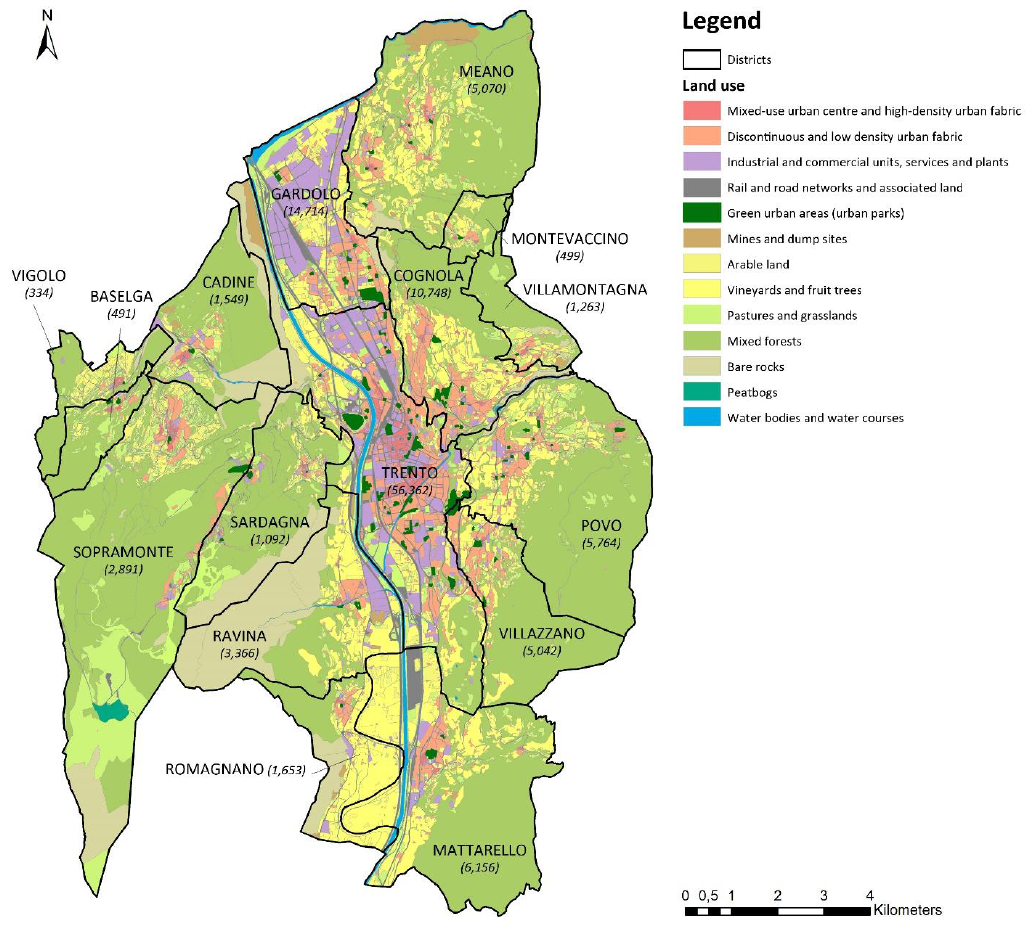
Figure 1. Main land uses in Trento [45] and the 16 districts used as spatial units for the analysis. In brackets: number of residents in each district (December 2014).